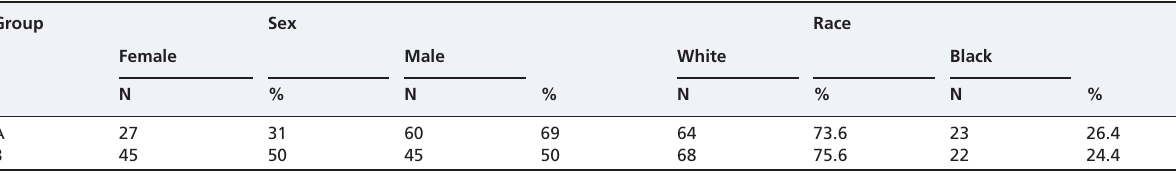
Table 1 - Distribution by sex and race of patients with vernal keratoconjunctivitis (Group A) and controls (Group B). Group Sex